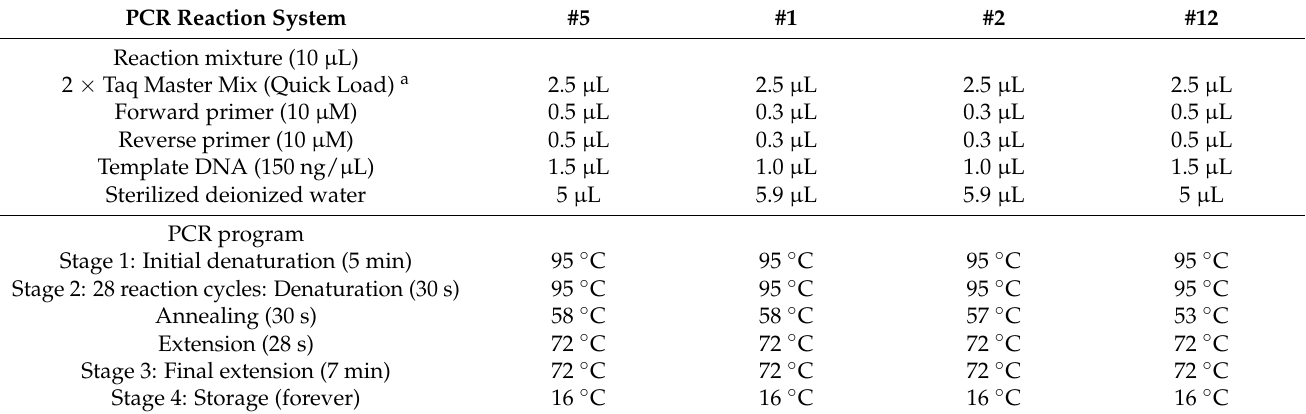
Table 2. The reaction system of AS-PCR for detecting offspring genotypes in bi-allelic mutant